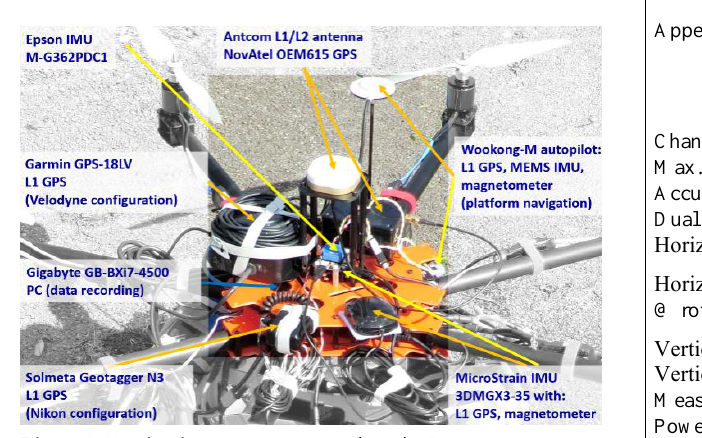
Figure 1. Navigation sensors mounted on the Bergen octocopter The platform was also equipped with Gigabyte GB-BXi7 4500 small computer for recording data obtained from the Velodyne laser scanner, NovAtel GPS receiver, and MicroStrain and Epson IMUs. Besides collecting GPS raw observations, the